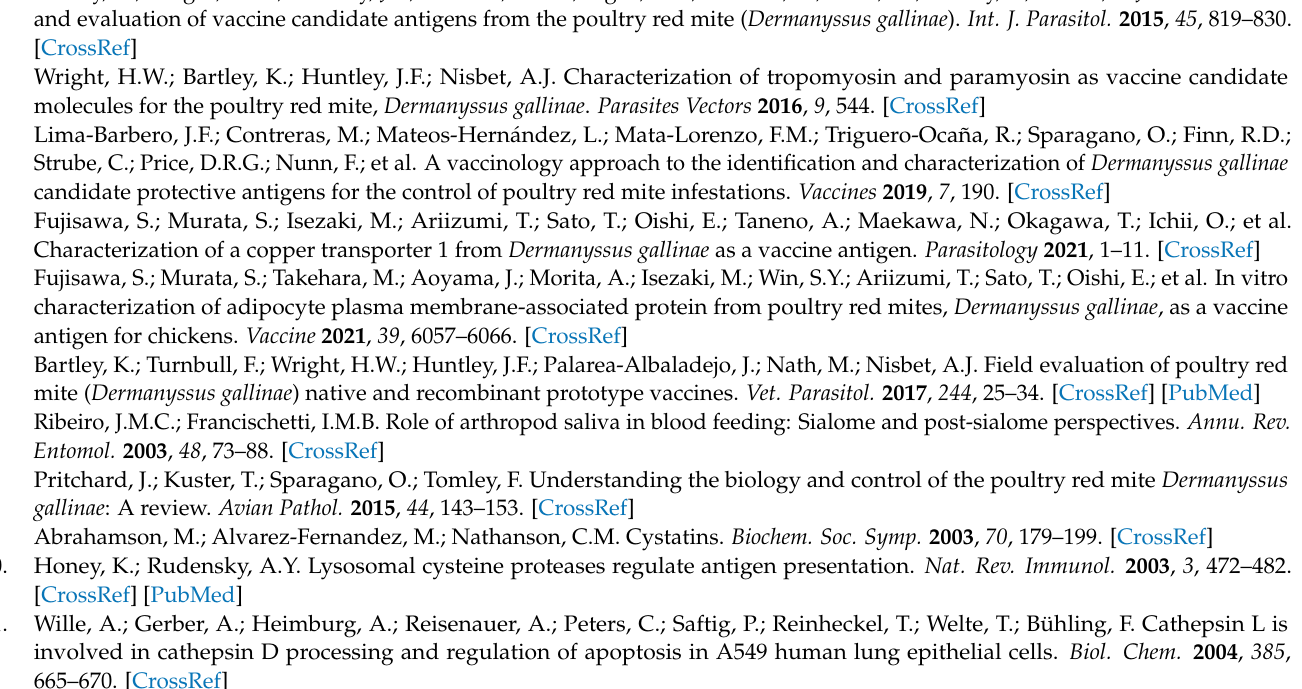
collection, Figure S2: Dg-Cys -his-specific antibody production of immunized chickens, Figure S3: The original uncropped image related to Figure 2, Figure S4:The original uncropped image related to Figure 3, Figure S5:The original uncropped image related to Figure S2, Table S1: Gene expression profiles of a cystatin-like molecule in poultry red mites (PRMs), Table S2: Antibody titers in the plasmas from chickens immunized with Dg-Cys